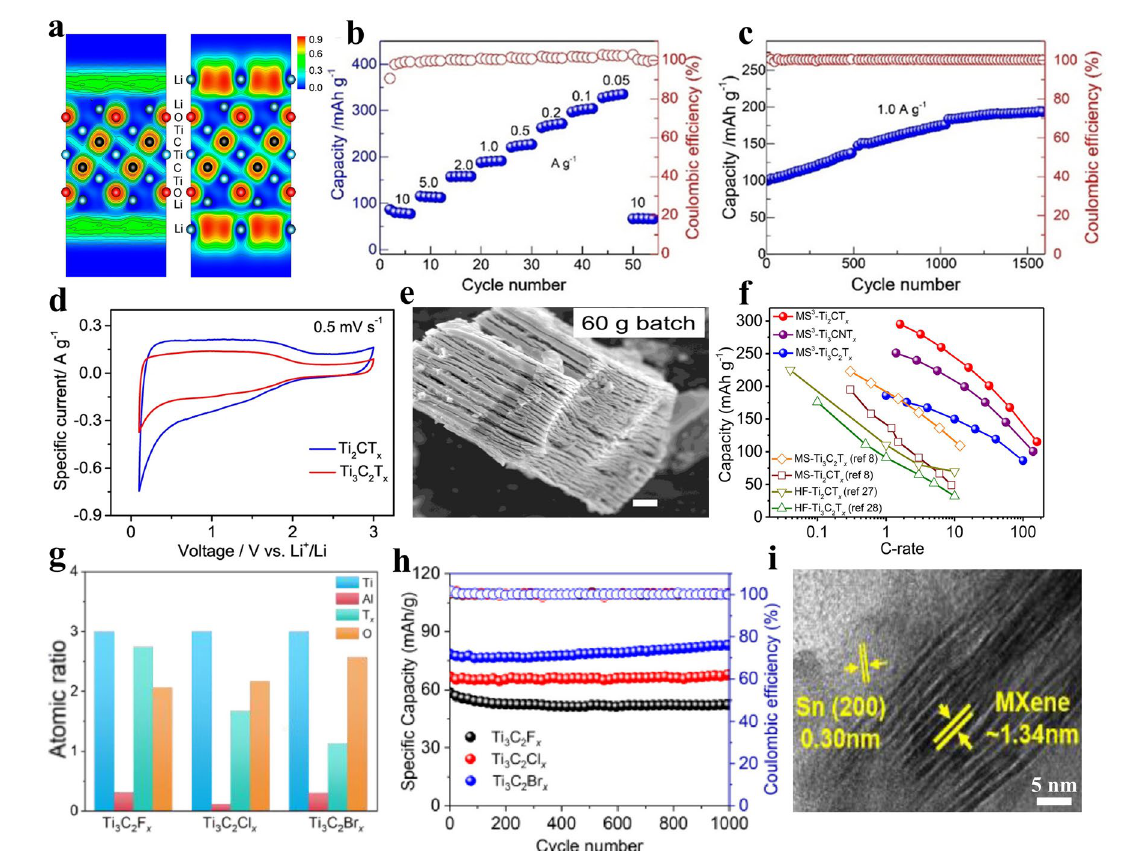
Fig. 10 a Valence electron localization function of Ti 3 C 2 O 2 Li 2 with or without an extra Li layer. Reproduced with permission from [120] Copy- right 2014, American Chemical Society. b Rate performance of Nb 2 CT x MXene. c Long-term cyclic performance of Nb 2 CT x MXene. Repro- duced with permission from [119] Copyright 2021, Wiley–VCH. d CV curves of Ti 2 CT x and Ti 3 C 2 T x MXene. Reproduced with permission from [112] Copyright 2021, The Authors, published by Springer Nature. e SEM image of Ti 3 C 2 T x MXene prepared from 60 batch of Ti 3 AlC 2 MAX. f Specific capacities of Ti 3 C 2 T x , Ti 2 CT x and Ti 3 CNT x MXene at various C-rates. Reproduced with permission from [175] Copyright 2022, Zheng- zhou University. g Elemental composition comparison of Ti 3 C 2 F x , Ti 3 C 2 Cl x and Ti 3 C 2 Br x MXenes. h Long-term cyclic performance of Ti 3 C 2 F x , Ti 3 C 2 Cl x and Ti 3 C 2 Br x MXenes at 1 A g −1 . Reproduced with permission from [178] Copyright 2022, Elsevier. i TEM image of Ti 3 C 2 T x /Sn anode after 2200 cycles. Reproduced with permission from [145] Copyright 2022,